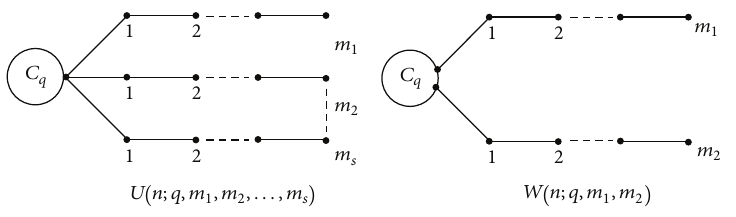
Figure 1: Two classes of unicyclic